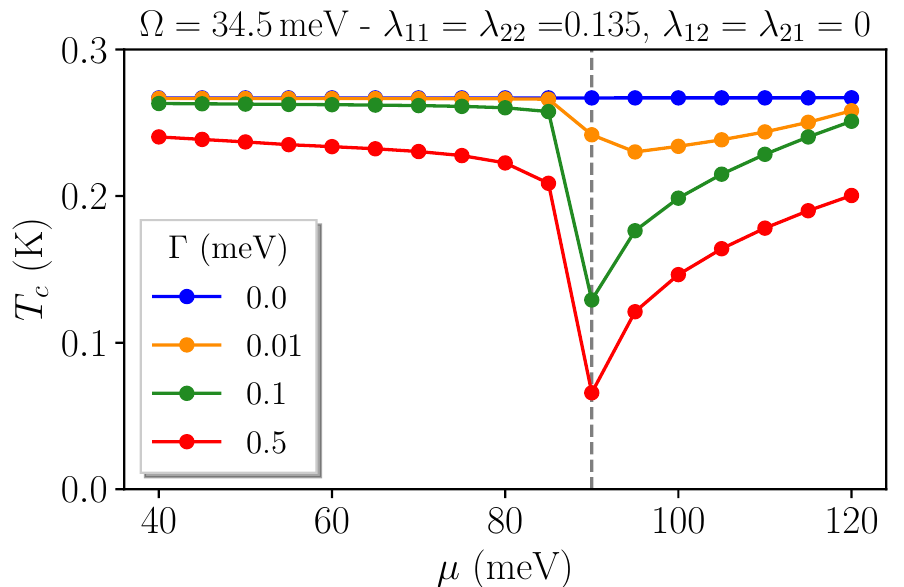
Figure 4. Two bands system with no inter-band coupling λ 12 = λ 21 = 0 and different amounts of disorder Γ , the grey dashed line indicating the chemical potential corresponding to the Lifshitz transition, that is, ε 0 = 90meV. Here the parameters used are comparable with the real ones of LAO/STO heterostructures ( Ω = 34.5 meV and λ 11 = λ 22 = 0.135. As one can see, already Γ = 0.01 meV is enough to couple the bands and lower the critical